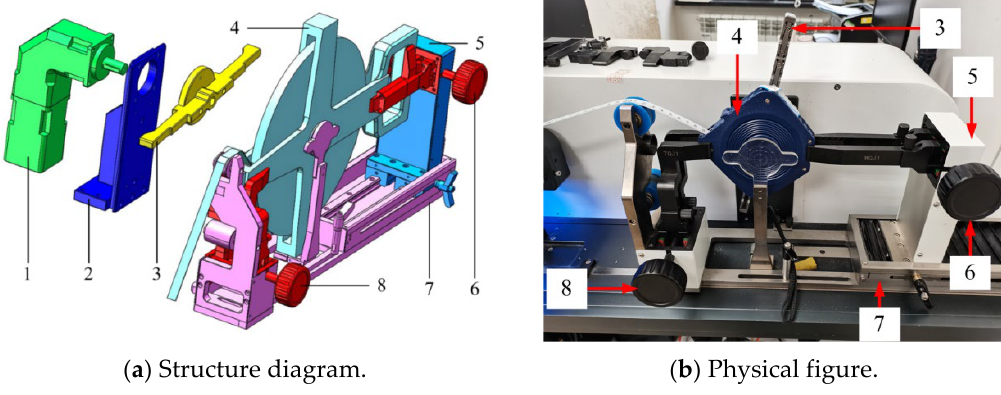
Figure 6. Tape retracting device: 1. Servo motor for tape retracting device; 2. fixed part for motor; 3.